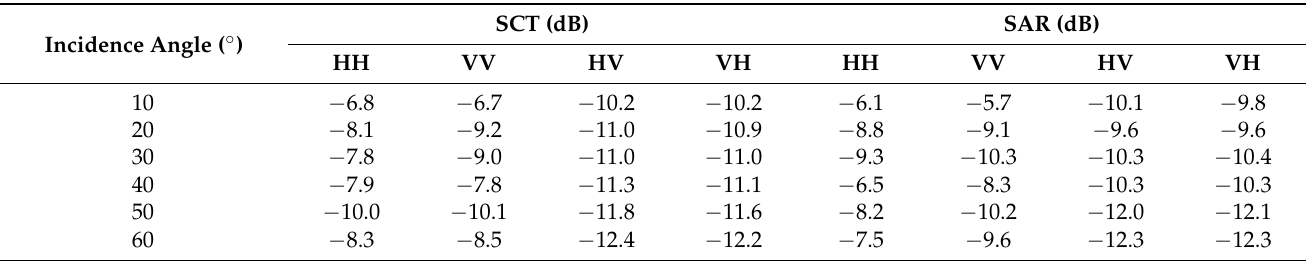
Table 6. Comparison of backscattering coefficients between scatterometric measurements and SAR images at the Ku band with incidence angles ranging from 10 ◦ to 60 ◦